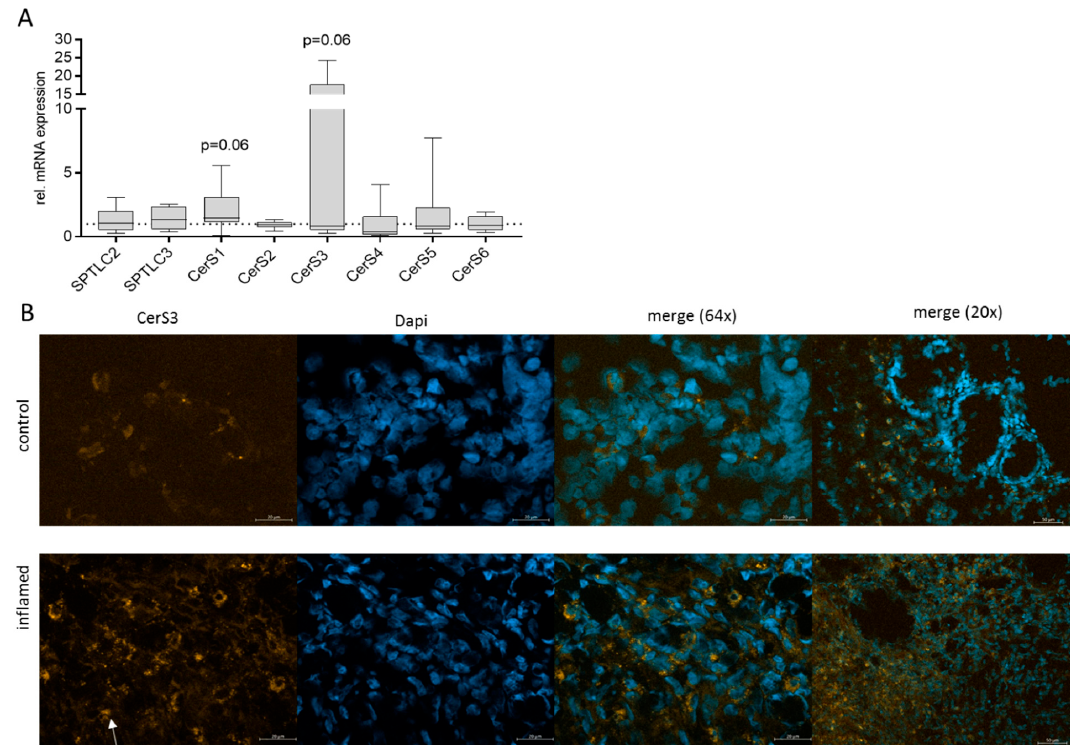
Figure 3: qRT-PCR and immunohistochemical staining of CerS and SPT in colon tissue. ( A ) mRNA levels of Sptlc2, Sptlc3 (SPT), CerS1-6 in inflamed and control tissue were detected by quantitative RT-PCR. CT levels were normalized to GAPDH and subsequently, related to the level of control (set to 1), using 2^(- ΔΔ CT) method. Data are means ± SEM; n = 10–15. Statistical differences were analyzed by GraphPad Prism using unpaired T-test, p ≤ 0.05. ( B ) Immunohistochemistry of CerS3 in human colon tissue. CerS3 was stained with an anti-CerS3 antibody and a secondary antibody coupled to Cy3 and tissue was co-stained with DAPI. Original magnification: 63x and 20x; white arrow indicates cytoplasmic CerS3 staining in cell localized in the lamina propria.